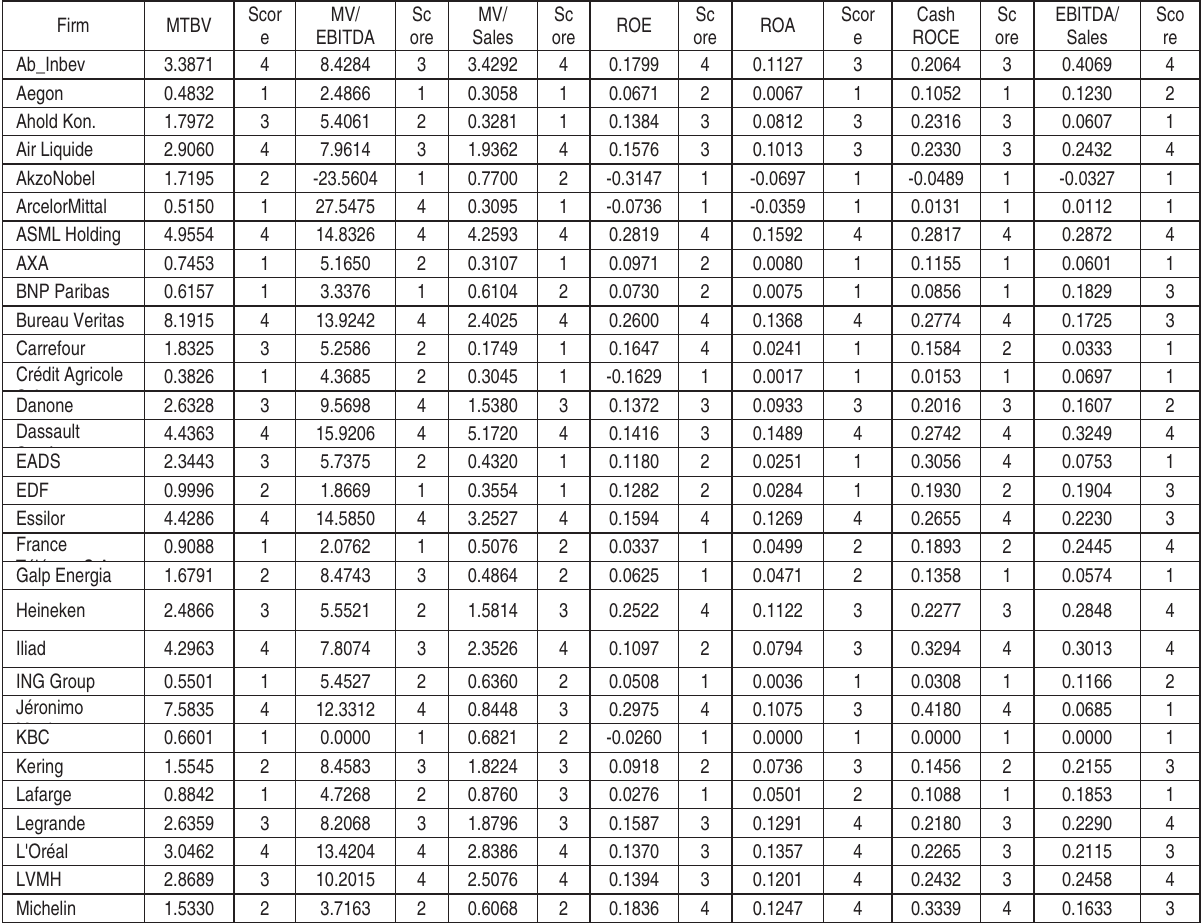
Table 4. Financial/market performance scores